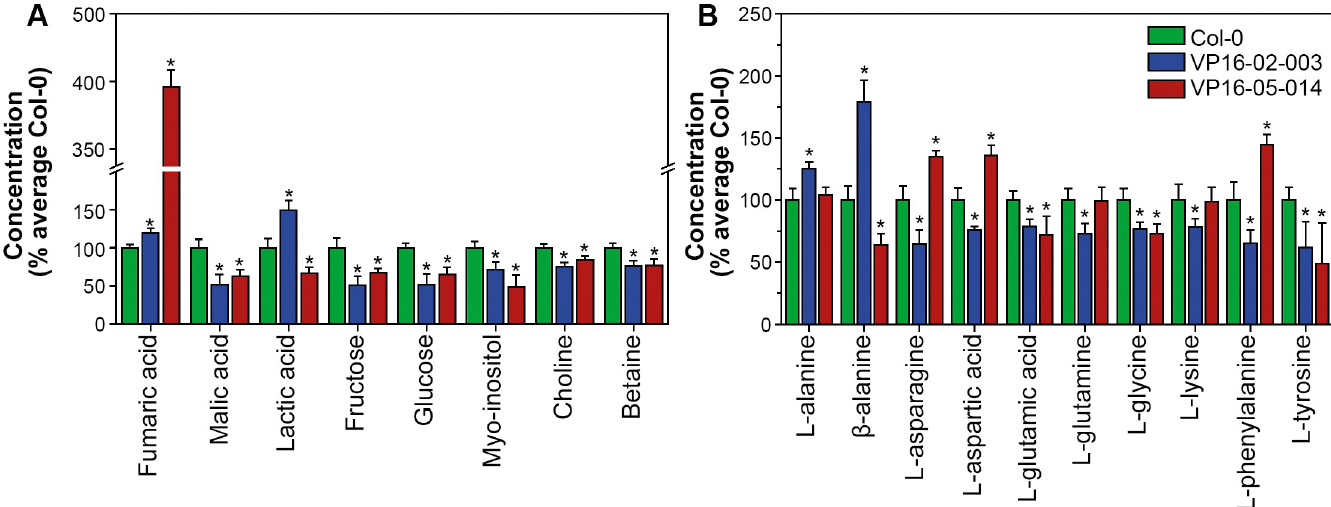
Fig 4. Metabolic alterations in the leaf of Arabidopsis thaliana VP16-02-003 and VP16-05-014 plants as compared to Col-0 plants grown in a 12h-light/12h-dark regime by 1 H HR-MAS NMR. (A) Relative levels of organic acids, sugars, sugar alcohol, precursor of cell wall components and organic osmolyte in leaves of VP16-02- 003 and VP16-05-014 plants in comparison to the level in Col-0. (B) Relative levels of free amino acids in leaves of VP16-02-003 and VP16-05-014 plants in comparison to Col-0. Concentrations are represented by the mean ± SEM averaged over n = 8 samples. The asterisks ( � ) indicate significant differences between concentrations for Col-0 and mutants, calculated with Student’s t-test (p < 0.05).